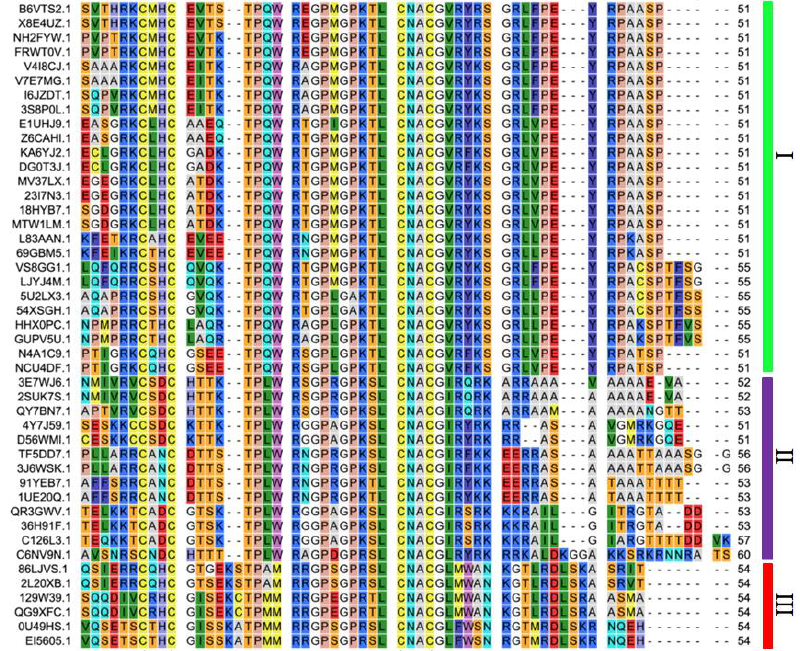
Figure 2. Alignments of GATA domains of all identified GATA family members in A. hypogaea L. The positions of highly conserved amino acids are marked with asterisk on the bottom.